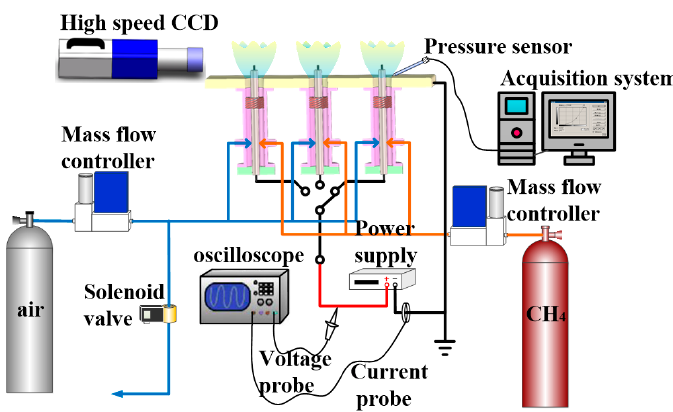
Figure 1. A schematic of the experimental system.